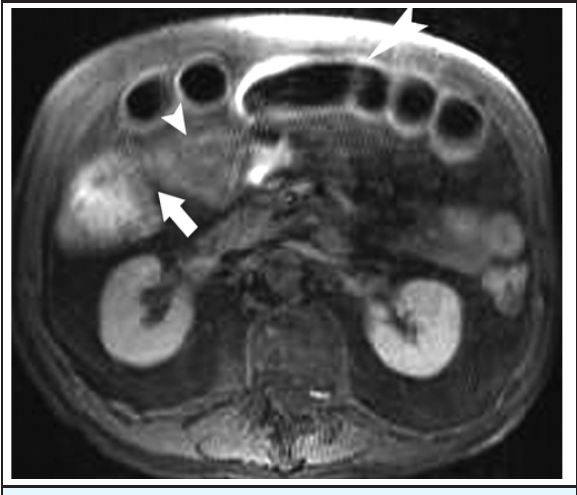
Figure 8a. MRI shows narrowing of large bowel (arrow) caused by mass (small white arrow head) with resultant proximal small bowel obstruction (large white arrow head).